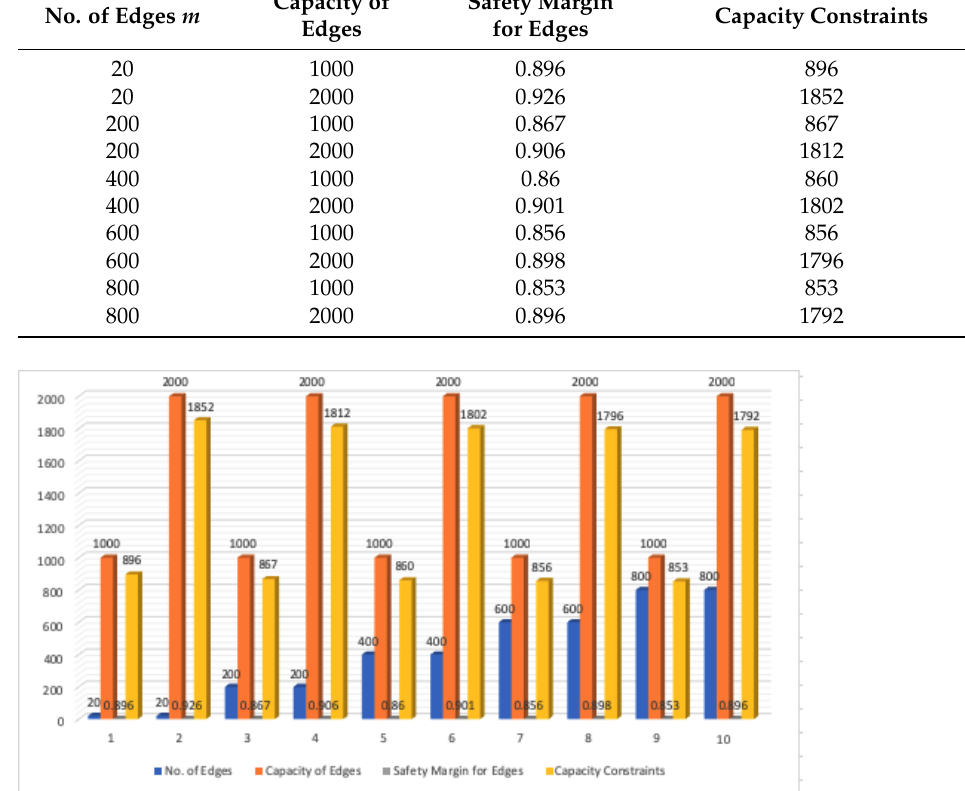
Figure 1. Safety margin and capacity constraints for